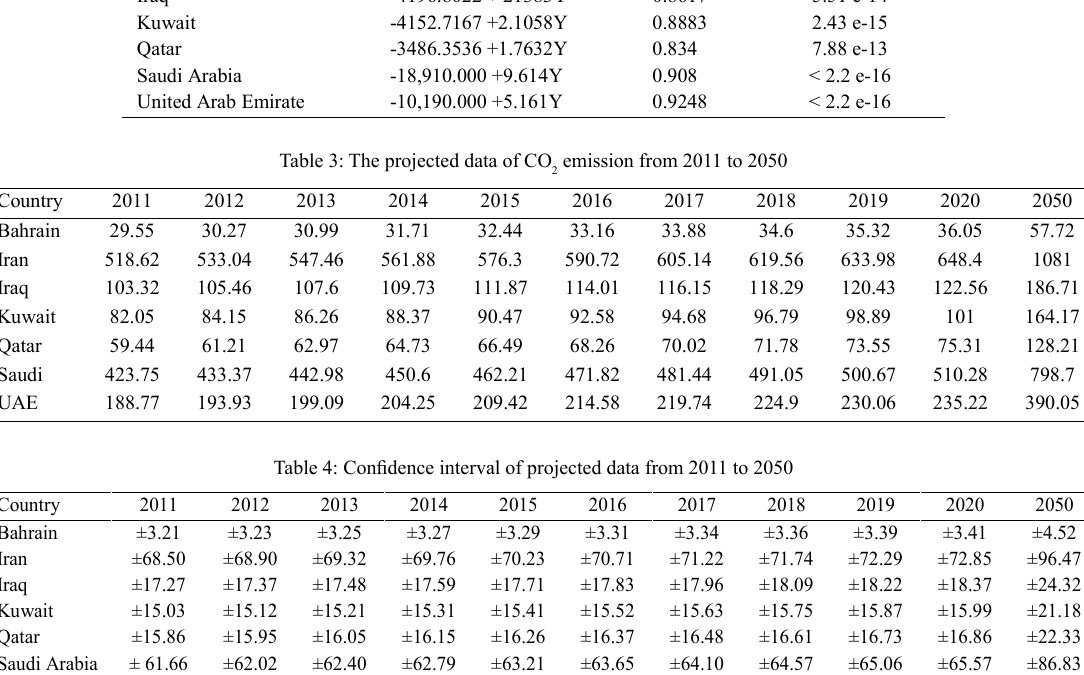
Table 2: Regression study by country in the Persian Gulf State from 1980 – 2008 Country